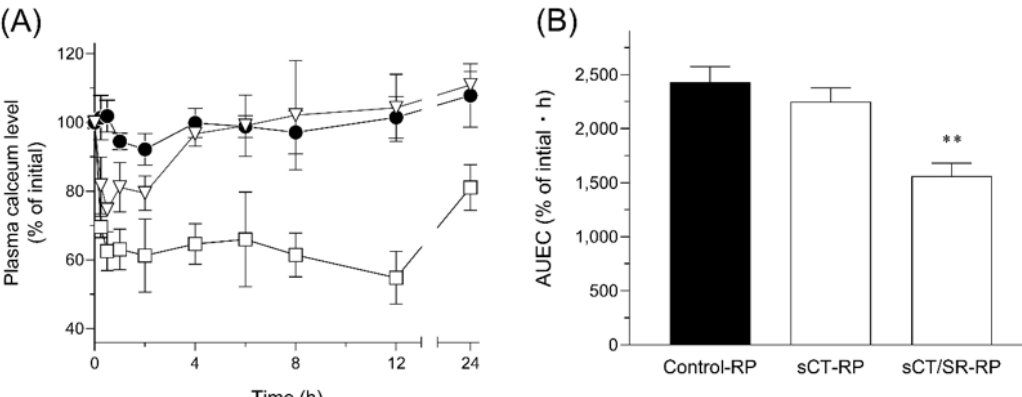
Figure 5. Hypocalcemic action of sCT after the intratracheal administration of sCT samples in rats (40 µg-sCT/kg, i.t. ). ( A ) Time transitions of plasma calcium levels after the administration of sCT samples and ( B ) AUEC 0–24 h of each group. ●, control-RP; ▽ , sCT-RP; and □, sCT/SR-RP. Data represent mean